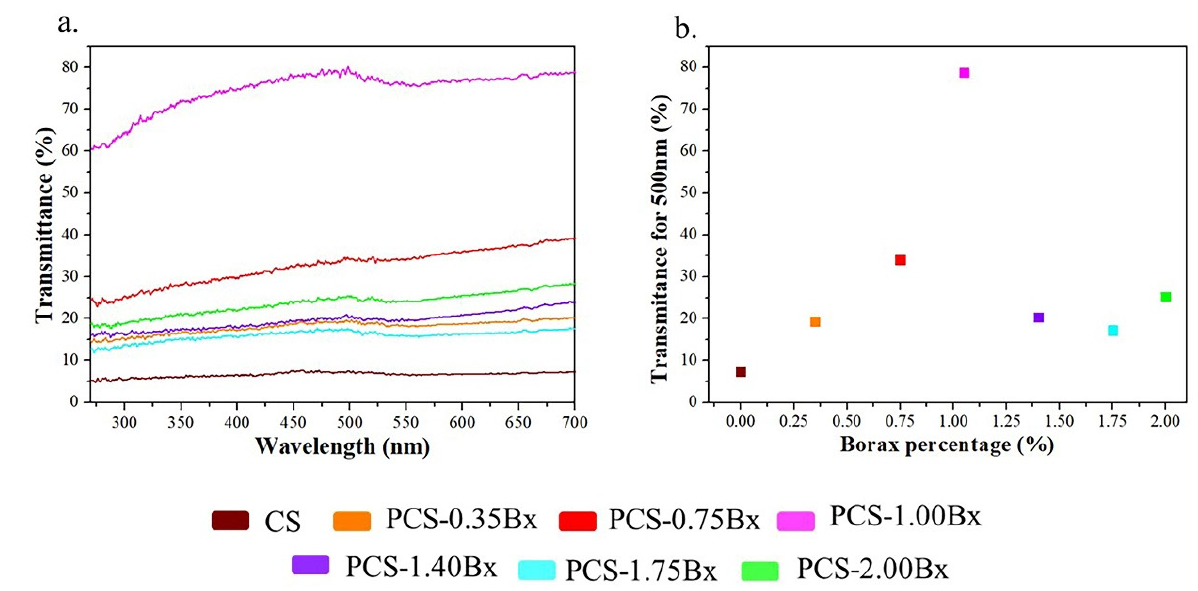
Figure 3. ( a ) Evolution of the UV-Vis transmittance spectra for samples with different borax contents and ( b ) transmittance at 500 nm.